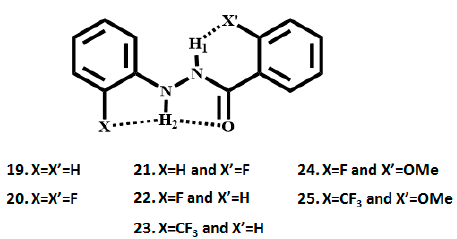
Figure 19. The chemical structures of N ′ -phenylbenzohydrazide and its halo derivatives. The dotted lines indicate the HB.